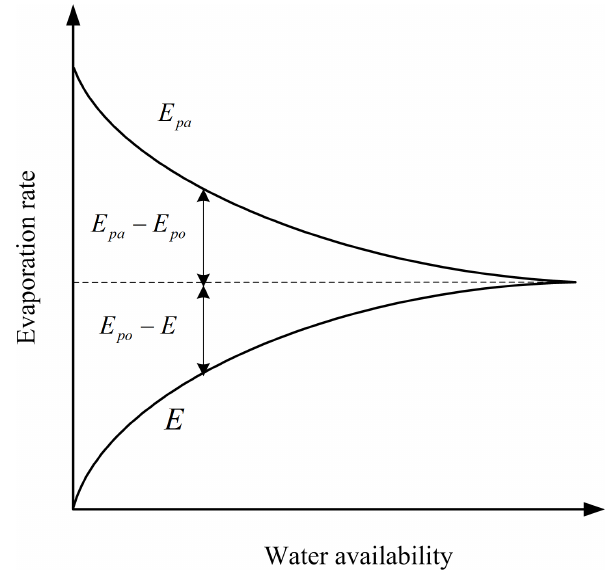
Figure 1. Schematic illustration of symmetric CR following Bouchet